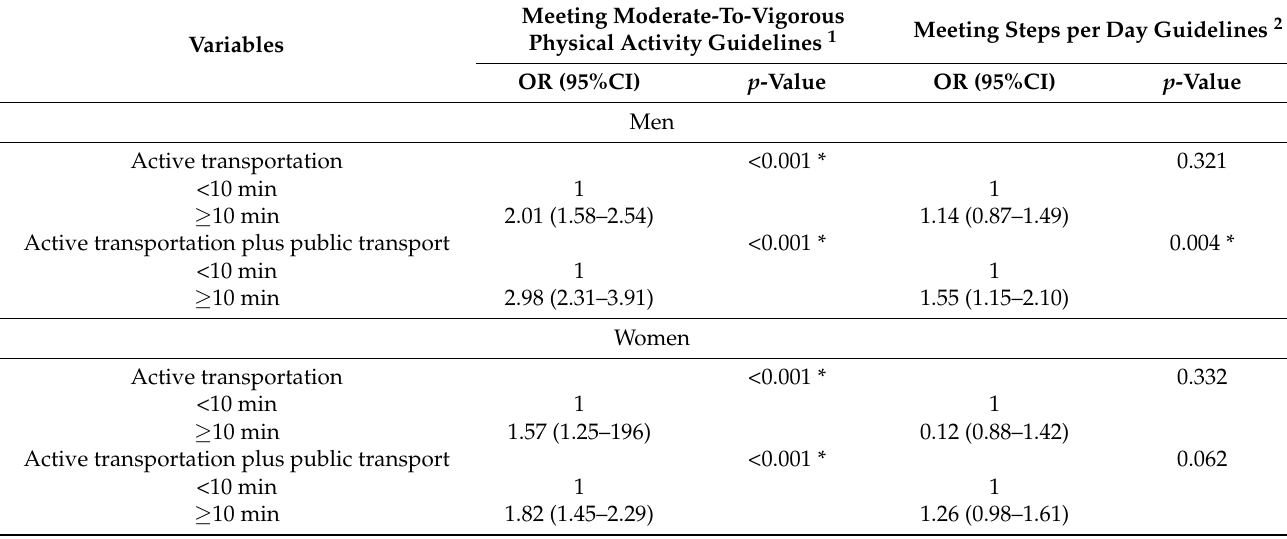
Table 3. Logistic regression (OR (95%CI)) for active transportation (also plus public transport) with meeting moderate-to- vigorous physical activity and steps per day